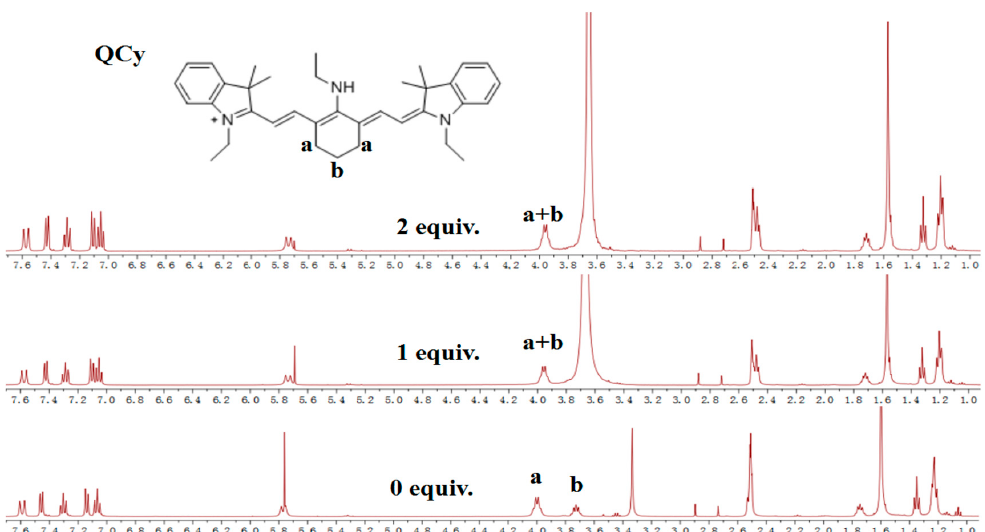
Figure 9. 1 H NMR spectra of QCy obtained upon an incremental addition of Ag + in DMSO ‐ d 6 .